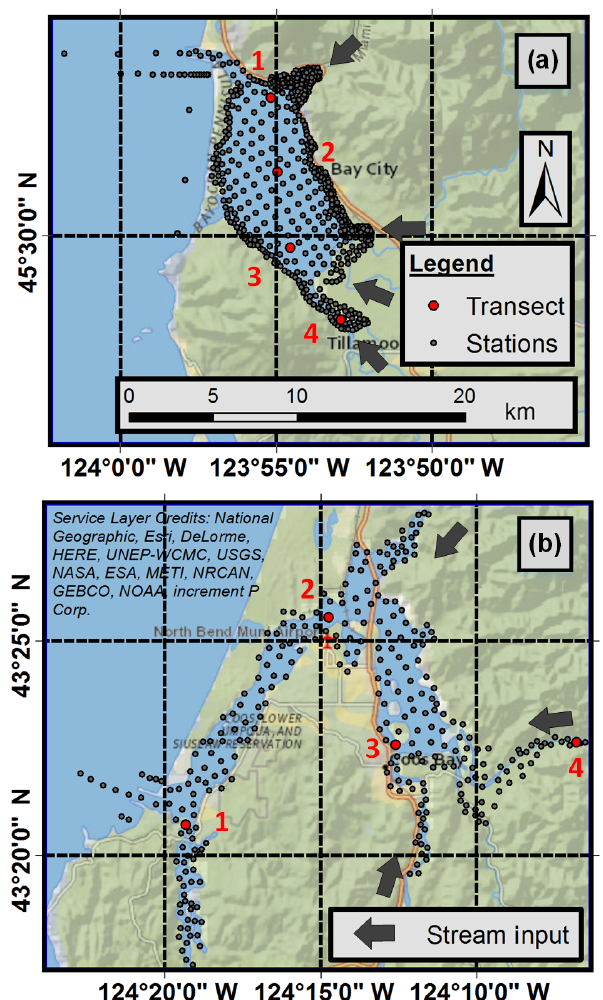
Figure 3. Station output locations at the Tillamook and Coos bay study sites, (a) and (b) , respectively. Gray arrows show hydrologic inputs into the model domain. Red points and numbers represent transect station locations (see Sect. 6.1). Both figures are at the same scale (a)